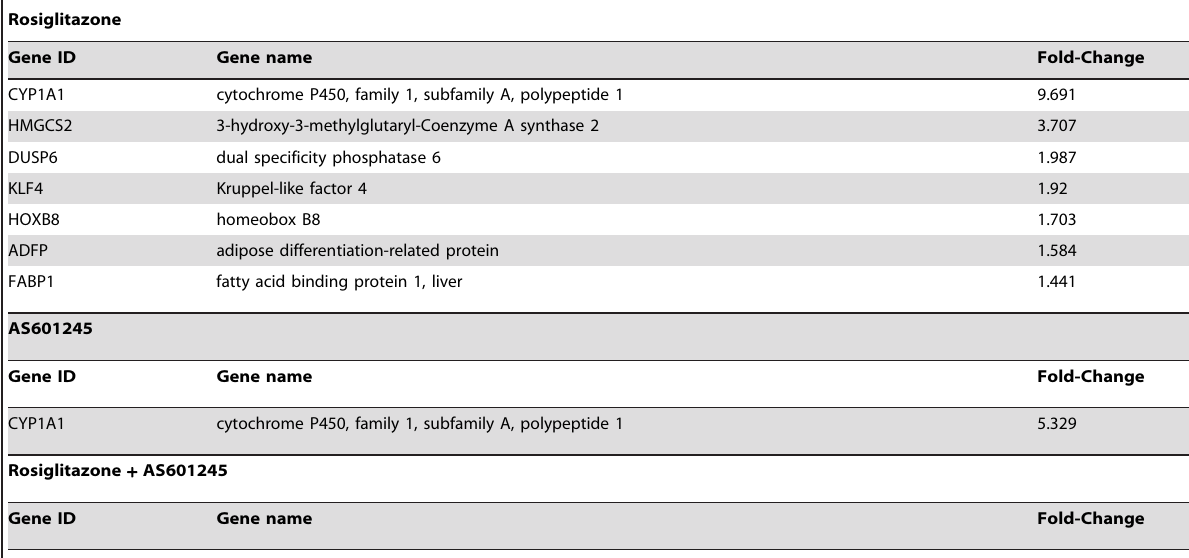
Table 5. Up-regulated genes containing PPRE sequences.